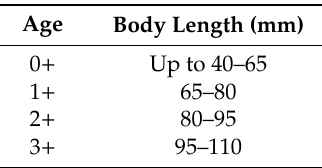
Table 1. Age-size classes of Orconectes limosus according to Pieplow